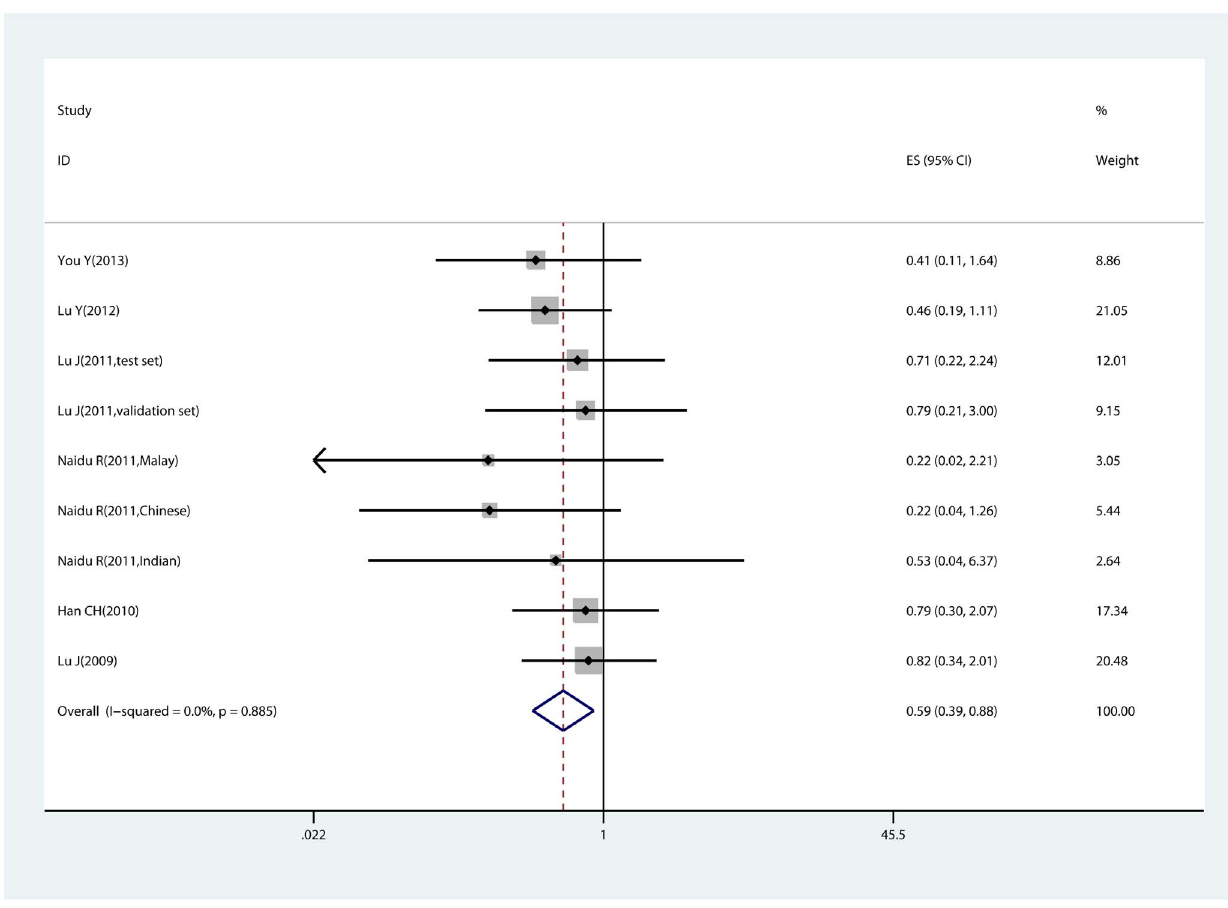
Figure 3. Forest plot of homozygote comparison (CC vs. GG) estimated by adjusted odds ratios. Homozygote comparison calculated with fixed-effects model. Odds ratio=0.589, 95% confidence intervals: 0.394–0.880.